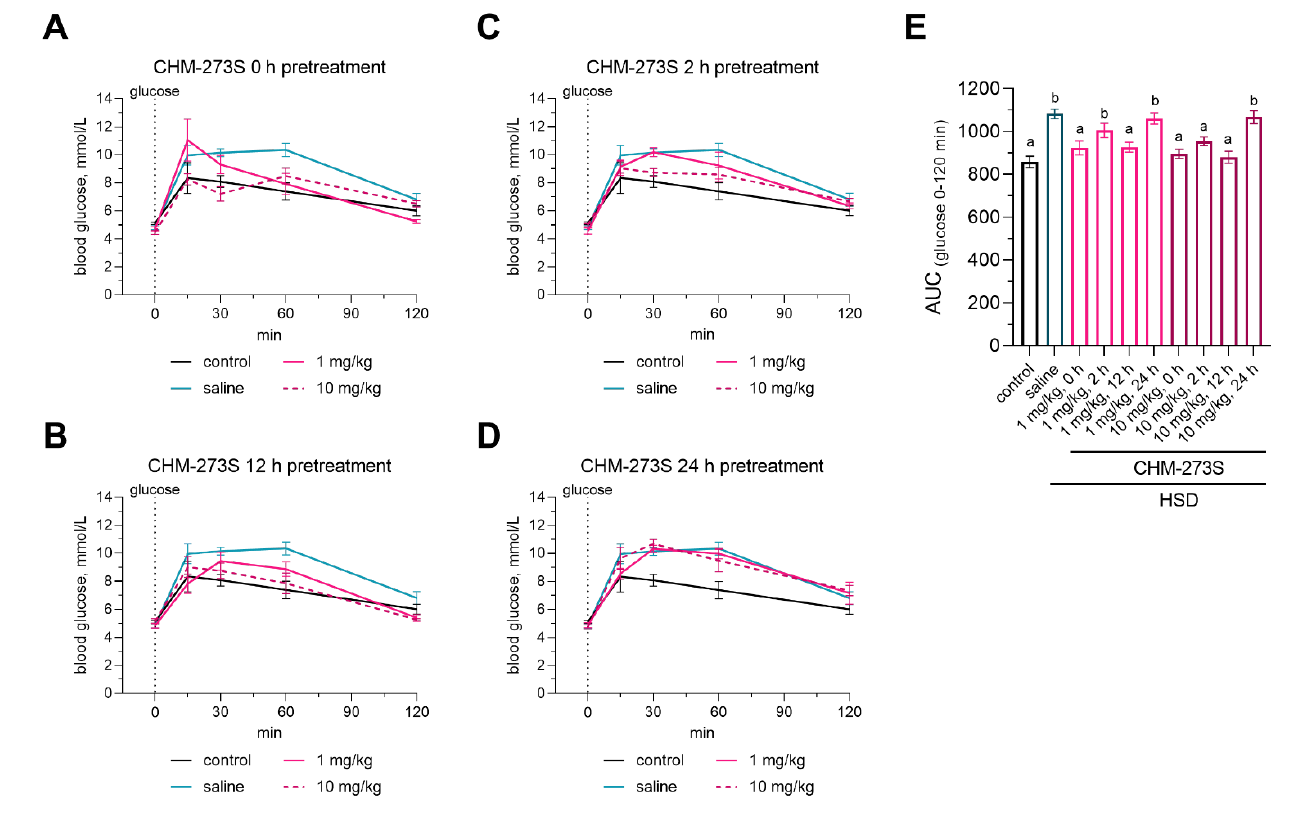
Figure 3. The effects of CHM-273S pretreatment on the oral glucose tolerance test (OGTT) in rats after they had consumed the high-sucrose diet (HSD) for 5 weeks. Blood glucose concentrations were measured by a glucometer after a 12 h fast at 0, 15, 30, 60, and 120 min following gavage with 2 g/kg of an oral glucose (40%) preload ( A ) 0 h, ( B ) 2 h, ( C ) 12 h, or ( D ) 24 h after intraperitoneal (i.p.) CHM-273S (1 or 10 mg/kg) treatment ( n = 5 each group). ( E ) Area under the curve (AUC) for the OGTT in HSD-fed rats after CHM-273S administration. Blood glucose levels were significantly higher in the HSD-fed, saline-treated group ( n = 5) and in HSD-fed, CHM-273S-treated rats (1 mg/kg 2 or 24 h or 10 mg/kg 24 h before OGTT, n = 5 each) (F (9,40) = 9.46, p < 0.0001). There was a significant reduction in blood glucose compared with the HSD-fed, saline-treated rats ( n = 5) in groups pretreated with 1 mg/kg (0 or 12 h before OGTT, n = 5 each) or 10 mg/kg CHM-273S (0, 2, or 12 h before OGTT, n = 5 each) (F (9,40) = 9.46, p < 0.0001). The results are presented as the mean ± standard error of the mean. Different superscript letters indicate significant differences at p < 0.05.; one-way analysis of variance with the Holm –Šídák multiple comparisons test.